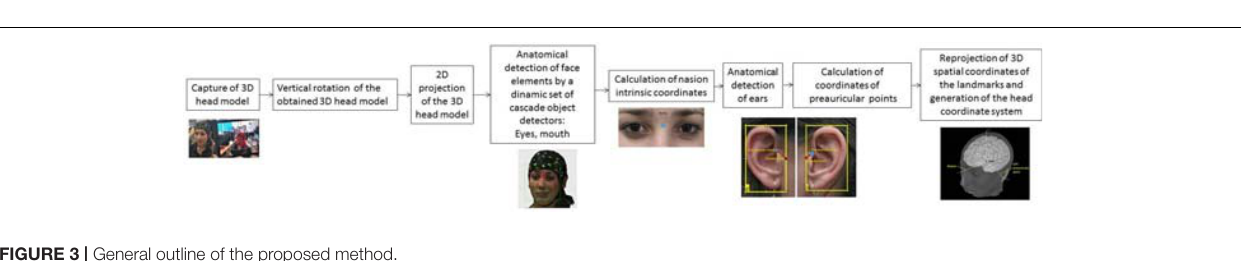
FIGURE 2 | (A) ST01 occipital structure sensor (Occipital Inc, 2019) and iPad A1893 (EveryMac.Com, 1996). (B) Scanning process around a subject.